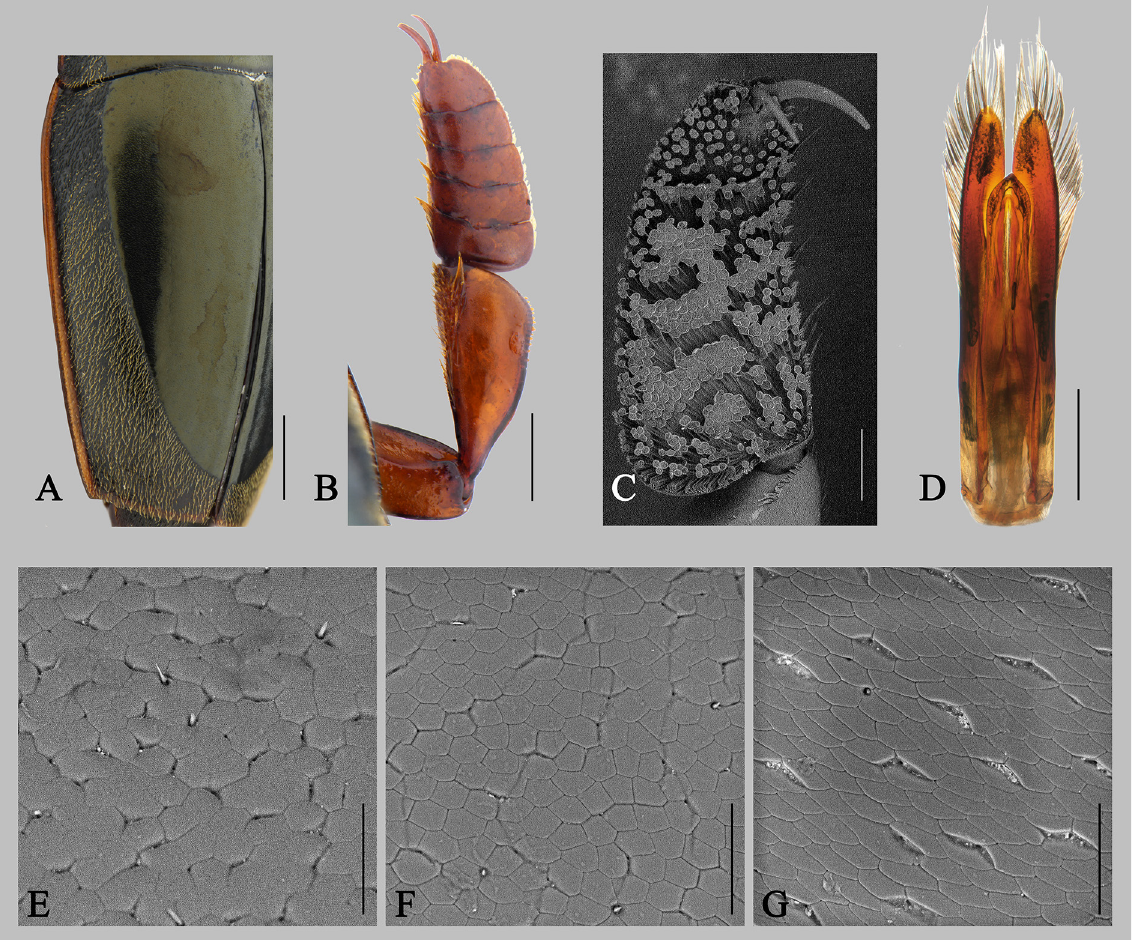
Fig. 4. Patrus jiangxiensis sp. nov., ♂ (SYSU). A . Left elytron, paratype. B . Front leg, paratype. C . Front tarsus, paratype. D . Genitalia, holotype. E . Surface sculpture on head, paratype. F . Surface sculpture on pronotum, paratype. G . Surface sculpture on elytra, paratype. Scale bars: A = 1 mm; B, D = 0.5 mm; C = 200 μm; E–G = 30